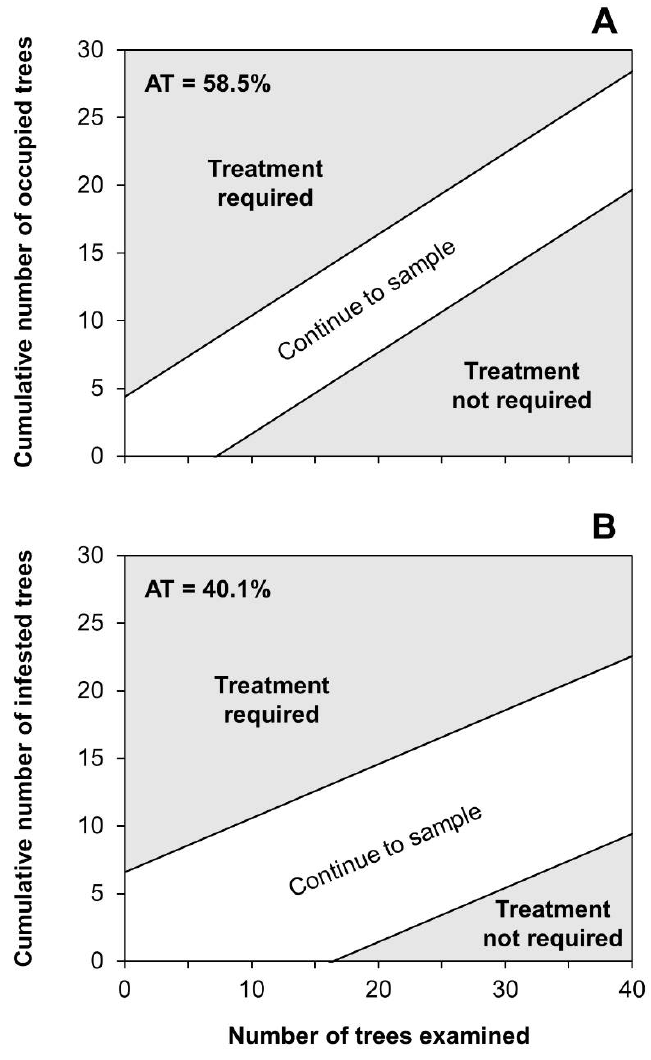
Figure 4. Decision stop lines for binomial sequential sampling plans of trees occupied ( A ) or infested ( B ) by Lymantria dispar in Mediterranean cork oak forests. Binomial plans were obtained from resampling validation analysis based on action thresholds of 58.5% ( A ) and 40.1% ( B ) of infested sample units, α and β = 0.1 and a tally threshold of 1 egg mass per tree ( A ) or 3 egg masses per tree ( B ).